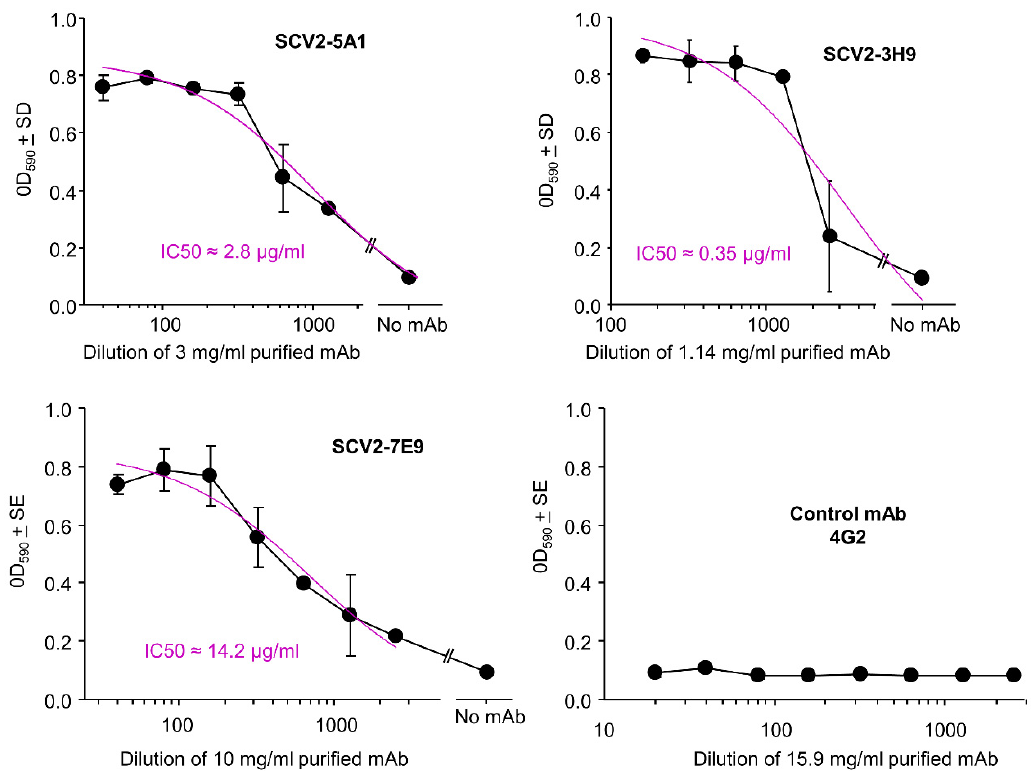
Figure 5. Virus neutralization assays. The indicated concentrations of purified antibodies were serially diluted in duplicate and used to neutralize SARS-CoV-2 QLD02 in Vero E6 CPE-based assays. High OD values illustrate cells protected from CPE by mAbs and thus staining with crystal violet, and low OD values represents a loss of cells via CPE resulting in loss of crystal violet staining; 50% inhibitory concentrations (IC50) were determined by interpolation. 100% CPE (0% neutralization) was determined in 8 replicates in wells without mAb. IC50 values were determined using the “log(inhibitor) vs. response” feature of GraphPad Prism (purple).